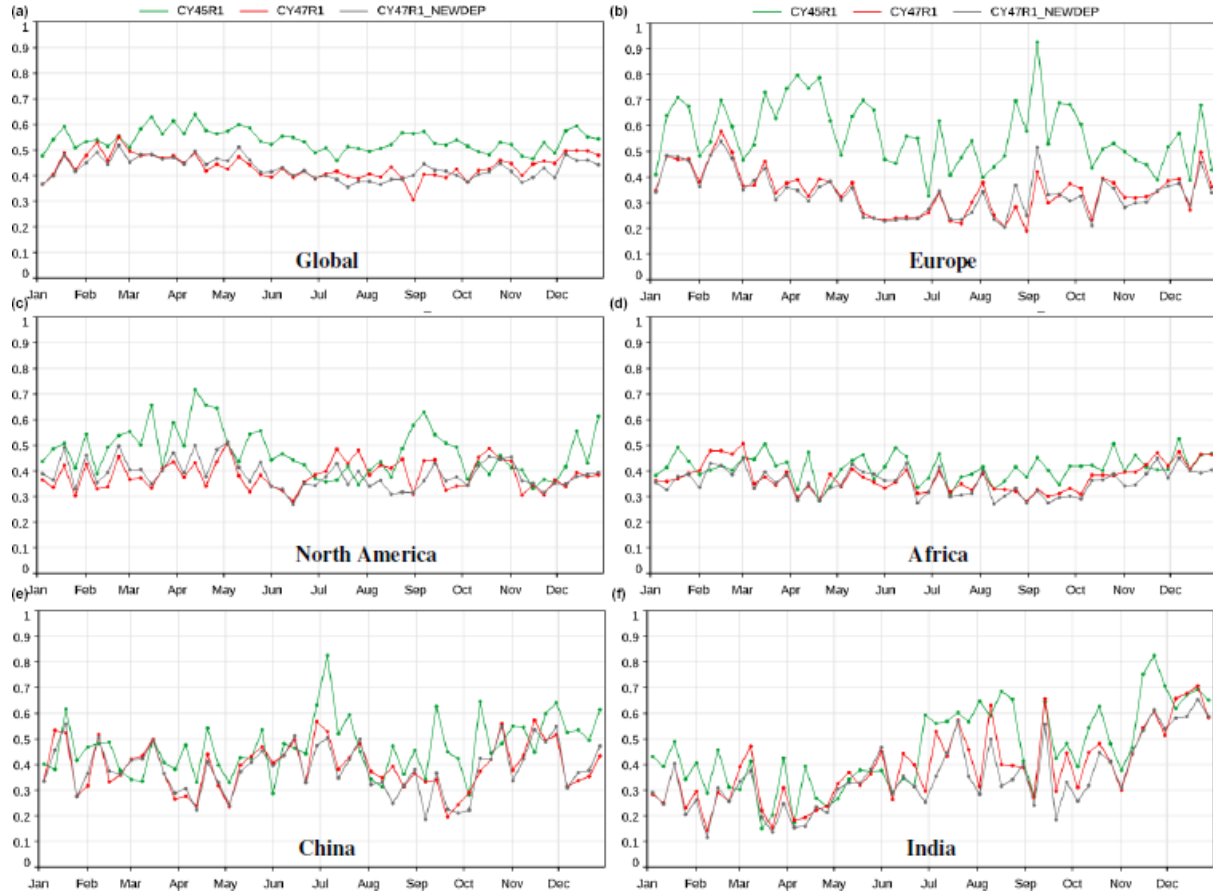
Figure 6. Fractional gross error (FGE) of simulated weekly AOD at 500nm against global (a) and regional (b) – (f) level 2 AOD from